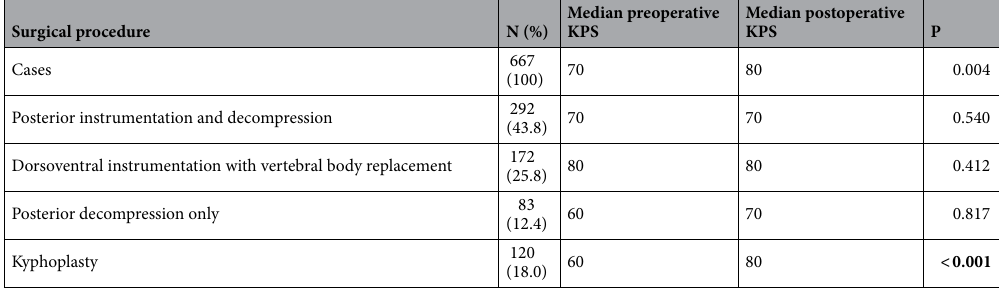
Table 2. Proportions of surgical techniques. N number, KPS Karnofsky performance scale score, P one-way ANOVA p